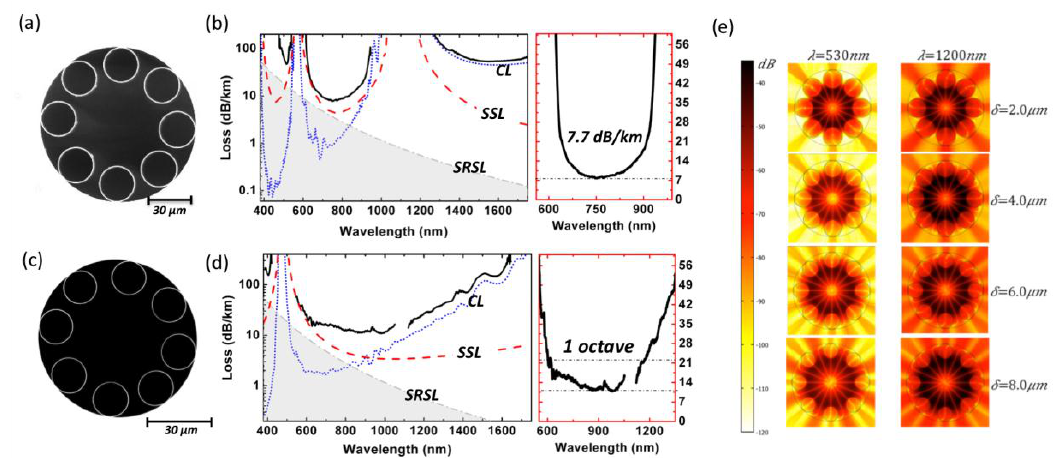
Figure 20. ( a , c ) SEM pictures of the fabricated 7.7 dB/km loss and broadband-guiding SR-TL HCPCFs, respectively. ( b , d ) Measured loss spectra of the two fibers (black curve) compared to theoretical SSL and CL evolutions. ( e ) Theoretical transverse distribution of radial component of Poynting vector for SR-TL fiber with different δ values from 2 to 8 µ m (Reprinted with permission from Reference [30], OSA,